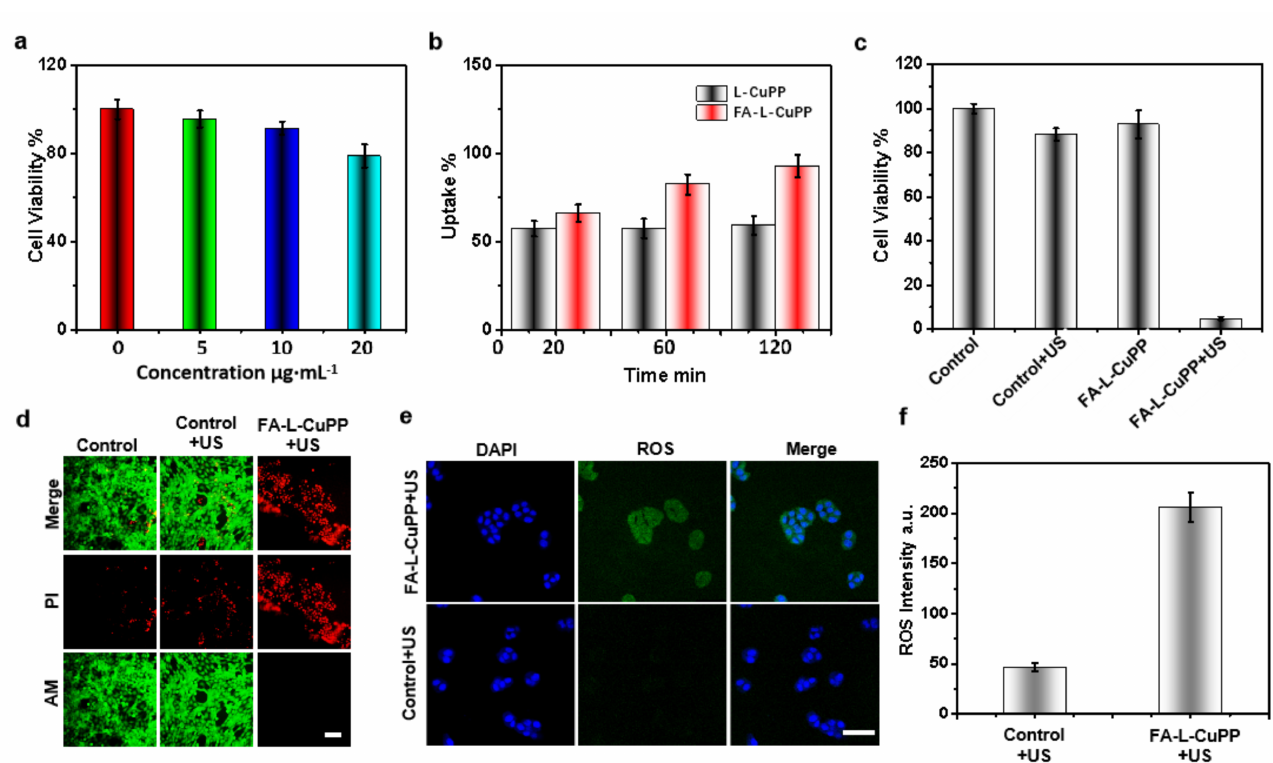
Figure 3. In vitro SDT effect of the FA–L–CuPP against 4T1 cells: ( a ) the in vitro cytotoxicity of the FA–L–CuPP with different concentrations against 4T1 cells. ( b ) The uptake of the FA–L–CuPP to the 4T1 cells (CuPP concentration of 10 µ g · mL − 1 ). ( c ) The sonocytotoxicity of the FA–L–CuPP (10 µ g · mL − 1 ) against 4T1 cells under US treatment (1.0 W · cm − 2 , 50% duty cycle, 2 min). ( d ) The FL imaging of 4T1 cells stained by PI and calcein − AM after various treatments; dead/later apoptosis cells were stained with PI (red), and viable cells were stained with calcein − AM (green) (scale bar = 25 µ m). ( e ) ROS imaging in 4T1 cells (DCFH − DA as a probe) after different treatments detected by CLSM (scale bar = 50 µ m). ( f ) The intracellular quantitation of ROS generation after different